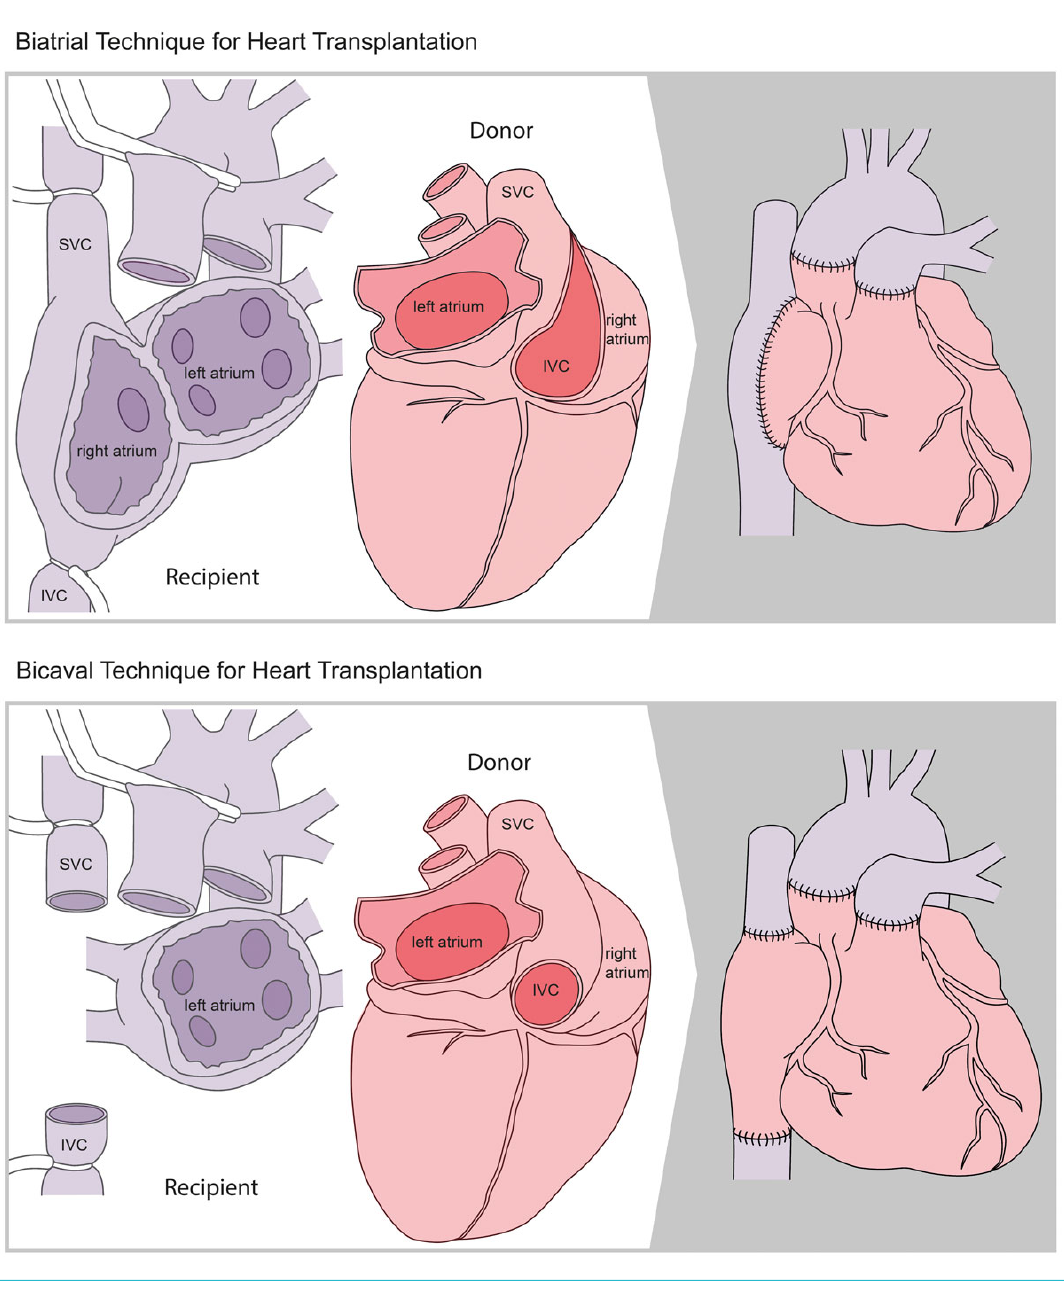
Figure 3: Illustration of the two different surgical techniques for heart transplantation. Upper panel: the classic biatrial technique. Lower panel: the modified bicaval